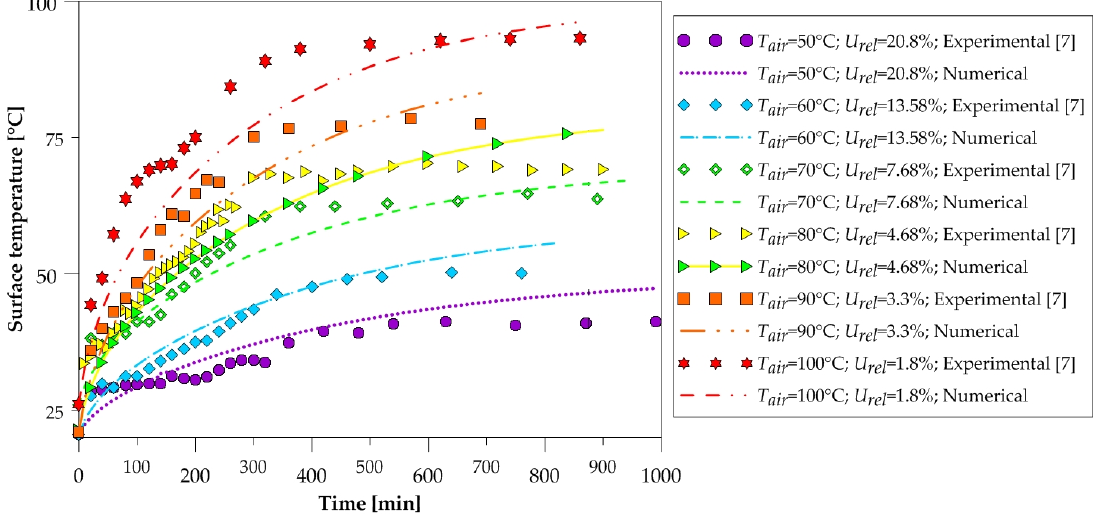
Figure 13. Temperature of the brick surface as a function of the drying time.